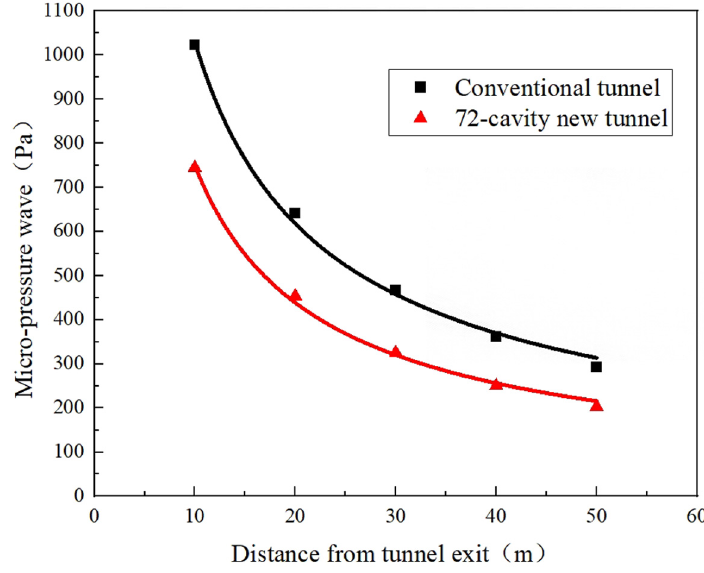
Figure 16. Micro-pressure wave fitting curves for different tunnel structures. Table 6. Micro-pressure wave fitting curves for different tunnel